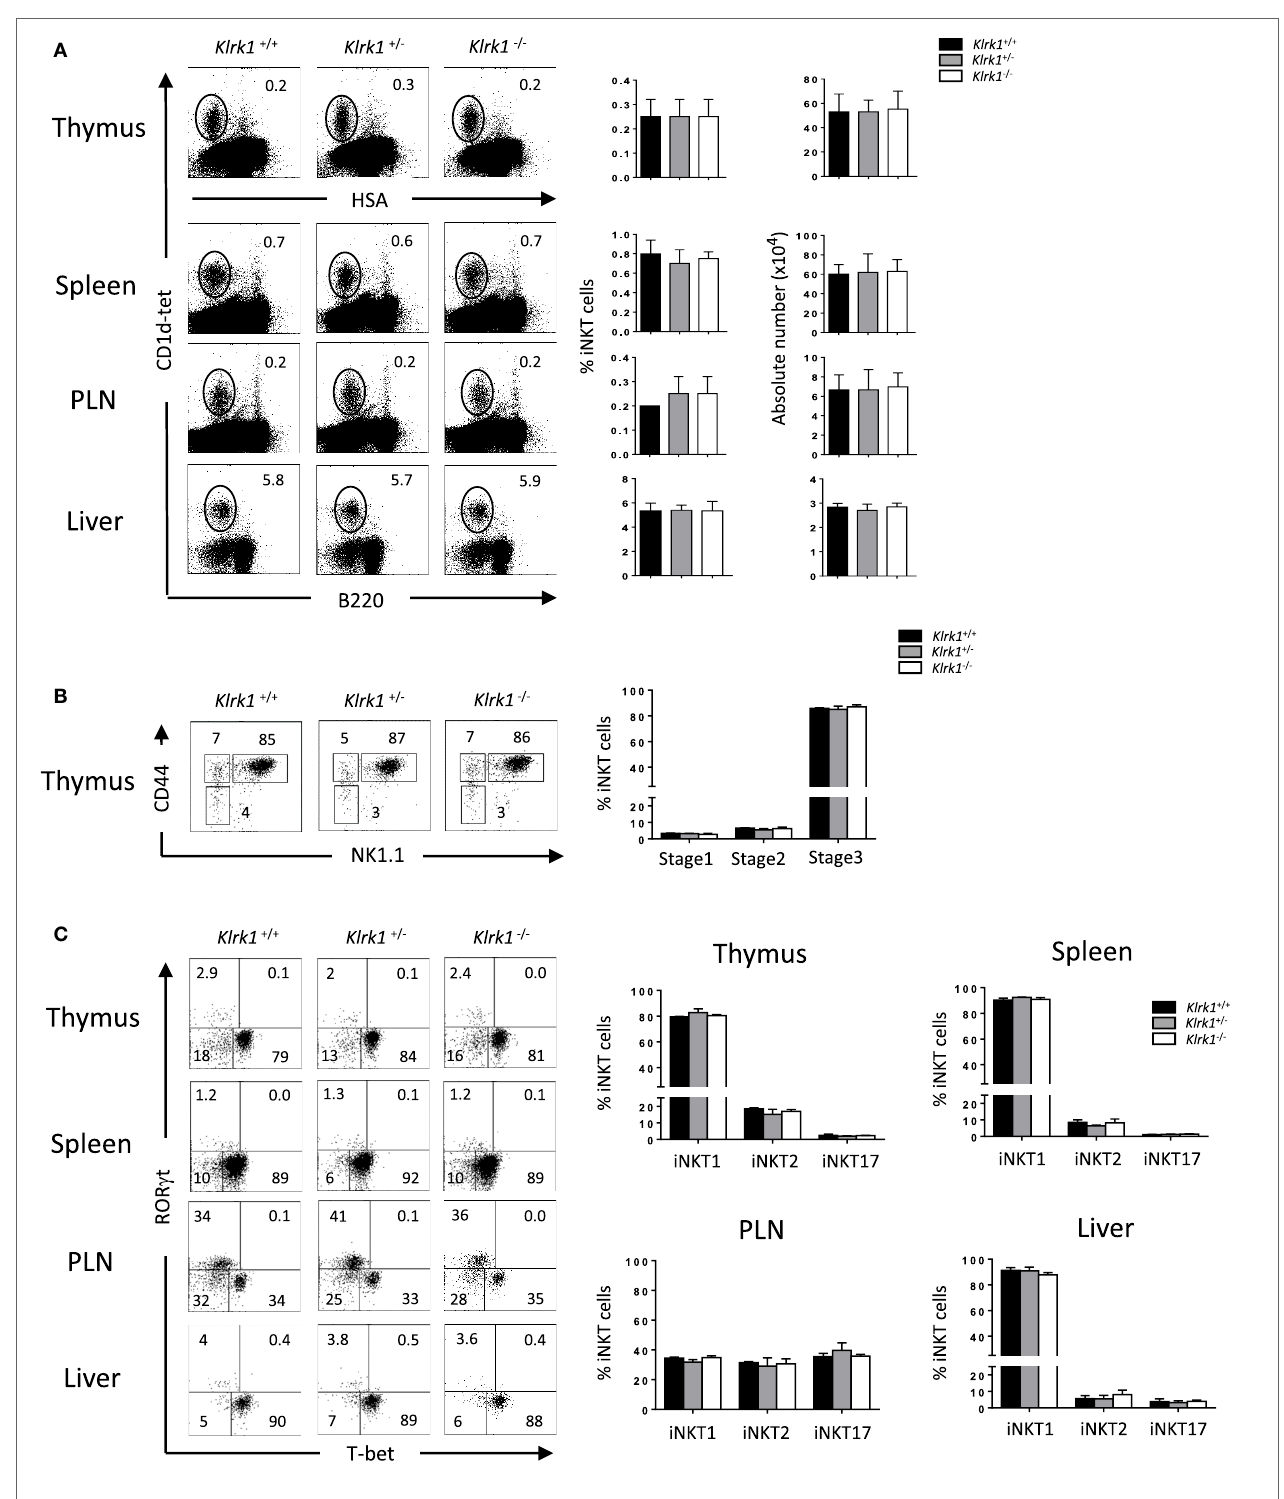
FigUre 1 | Normal development of invariant natural killer T cell (iNKT) cells in the absence of NK group 2 member D (a) . Representative Flow cytometry analysis of iNKT cells in the thymus, spleen, PLN, and liver. iNKT cells are defined as tet + HSA low in the thymus or tet + B220 − in the periphery. Histograms show frequency of iNKT cells. (B) Representative dot plot of NK1.1/CD44 gated on thymic tet + HSA low cells. Histogram plots show the frequency of iNKT cells at stage 1 (CD44 − NK1.1 − ), stage 2 (CD44 + NK1.1 − ), and stage 3 (CD44 + NK1.1 + ) of iNKT cell development. (c) Representative staining of iNKT1 (T-bet + ), iNKT2 (ROR γ t − /T-bet − ), and iNKT17 (ROR γ t + ) subsets among iNKT cells at the indicated organs. Frequencies of these different subsets are represented in histograms. Data are from five experiments where three mice aged 5–6 week were used per experiment and presented as mean ± SD. Numbers represent percentages.